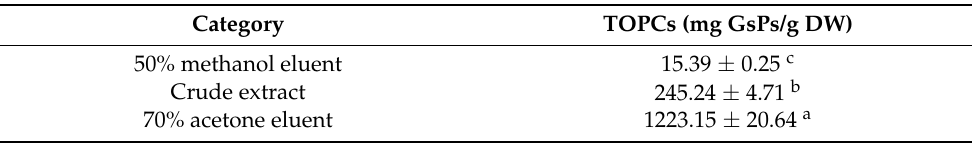
Different lowercase letters in each column indicate significant differences at the p < 0.05 level.